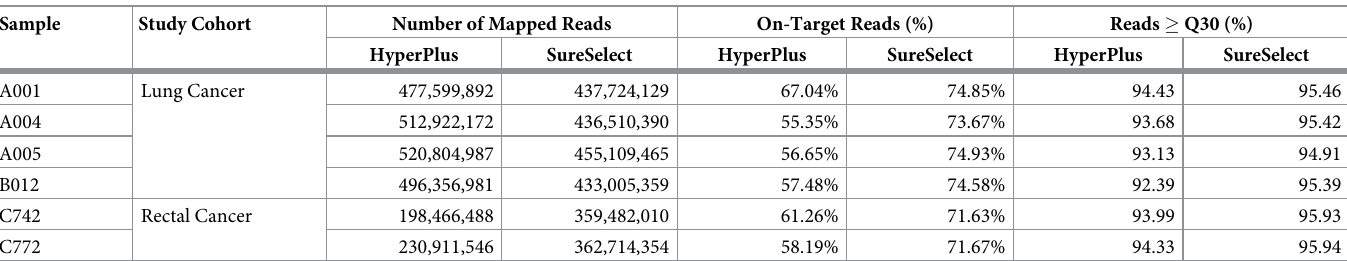
Table 1. Quality assessment of